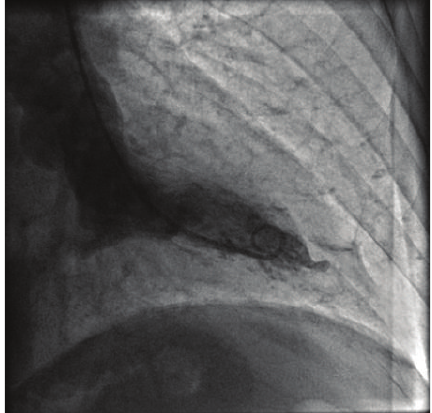
Figure 4: Cardiac